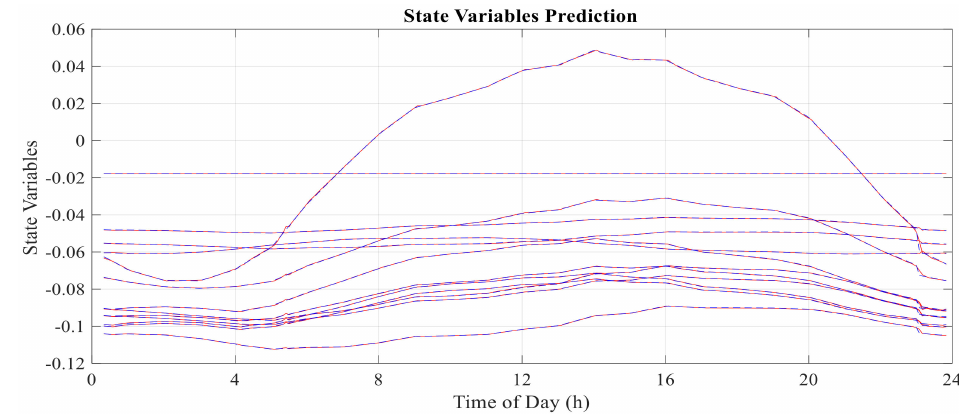
Figure 9. Results of RNARXNN-based state variable estimation in FDIA time